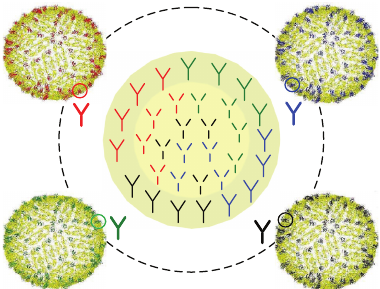
Figure 3: DENV-1, DENV-2, DENV-3, and DENV-4 with EDIII (circled) in red, green, blue, and black, respectively. EDIIIs elicit strongly neutralizing serotype-specific antibodies (antibodies in bold). Owing to homology especially in domains (EDI/II and prM) in yellow, cross-reactive weakly neutralizing antibodies (unbold antibodies) and nonneutralizing enhancing antibodies (dashed antibodies) are elicited in